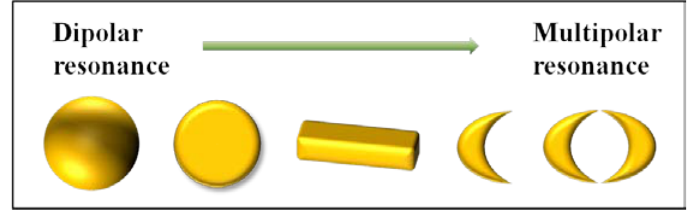
Figure 3. Schematic diagram for describing the polar properties of various nanostructures that are used in LSPR